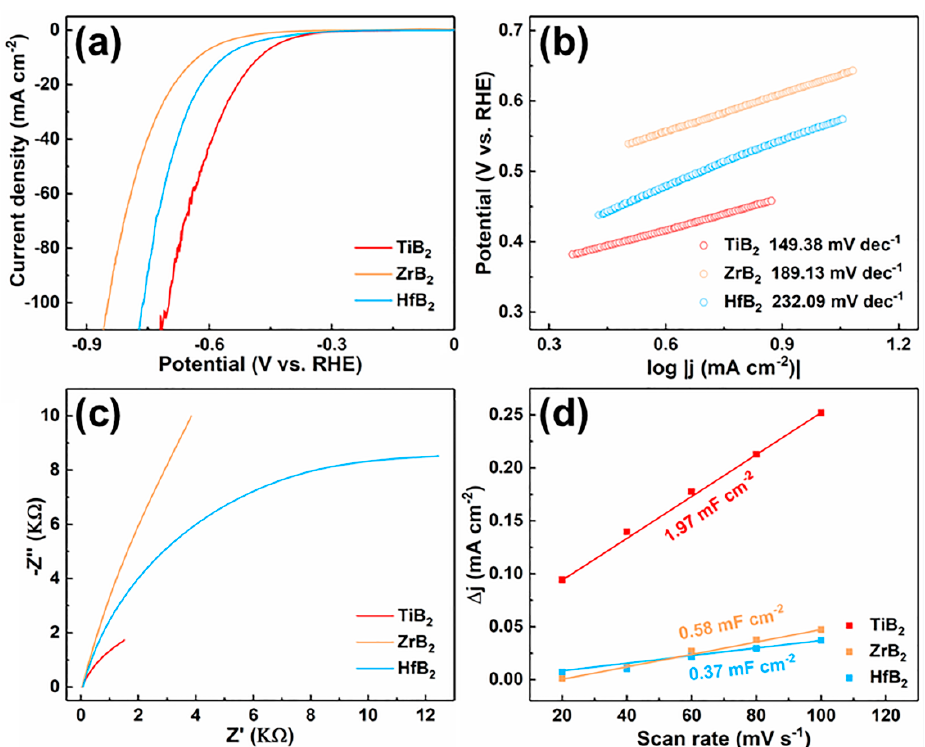
Figure 3. ( a ) The linear sweep voltammetry (LSV) curves of TiB 2 , ZrB 2 and HfB 2 after HPHT treatment for HER in 0.5 M H 2 SO 4 solution, ( b ) Tafel slopes of TiB 2 , ZrB 2 and HfB 2 after HPHT treatment, ( c ) EIS Nyquist plots of TiB 2 , ZrB 2 and HfB 2 after HPHT treatment, ( d ) ECSA fitting curves of TiB 2 , ZrB 2 and HfB 2 after HPHT treatment.